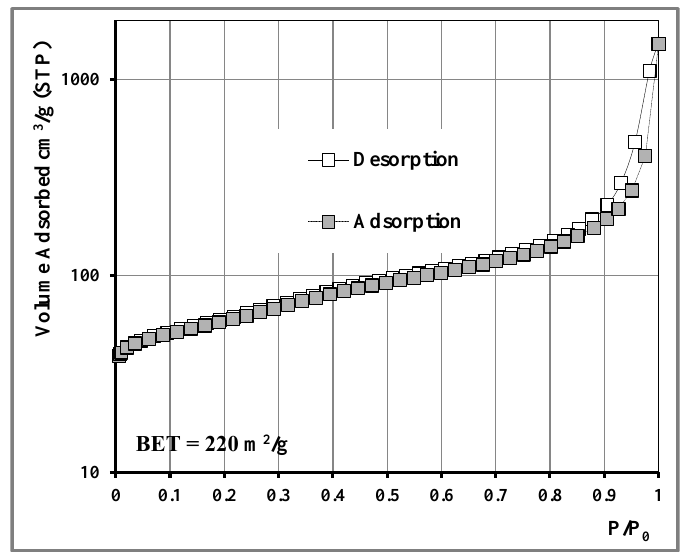
Figure 3. N 2 adsorption isotherm at 77 K of MWCNTs.